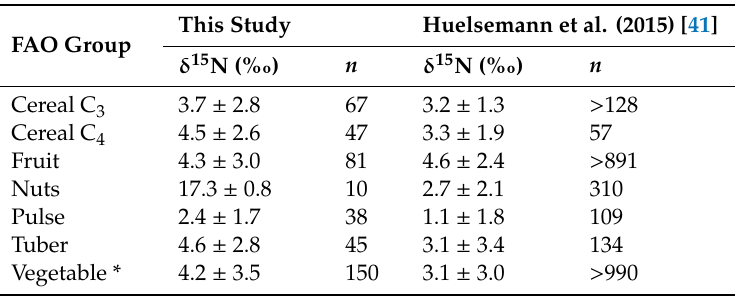
Table 3. Comparison of average δ 15 N (% (cid:24) ) of domesticated plants reported this study and those in the meta-analysis of Huelsemann et al. (2015) [41]. Plants were grouped following the FAO classification. The values represent mean ± standard deviation. This Study Huelsemann et al. (2015) [41] FAO Group δ 15 N (% (cid:24) ) n δ 15 N (% (cid:24) ) n Cereal C 3 3.7 ± 2.8 67 3.2 ± 1.3 > 128 Cereal C 4 4.5 ± 2.6 47 3.3 ± 1.9 57 Fruit 4.3 ± 3.0 81 4.6 ± 2.4 > 891 Nuts 17.3 ± 0.8 10 2.7 ± 2.1 310 Pulse 2.4 ± 1.7 38 1.1 ± 1.8 109 Tuber 4.6 ± 2.8 45 3.1 ± 3.4 134 Vegetable * 4.2 ± 3.5 150 3.1 ± 3.0 > 990 * Amended with mineral nitrogen